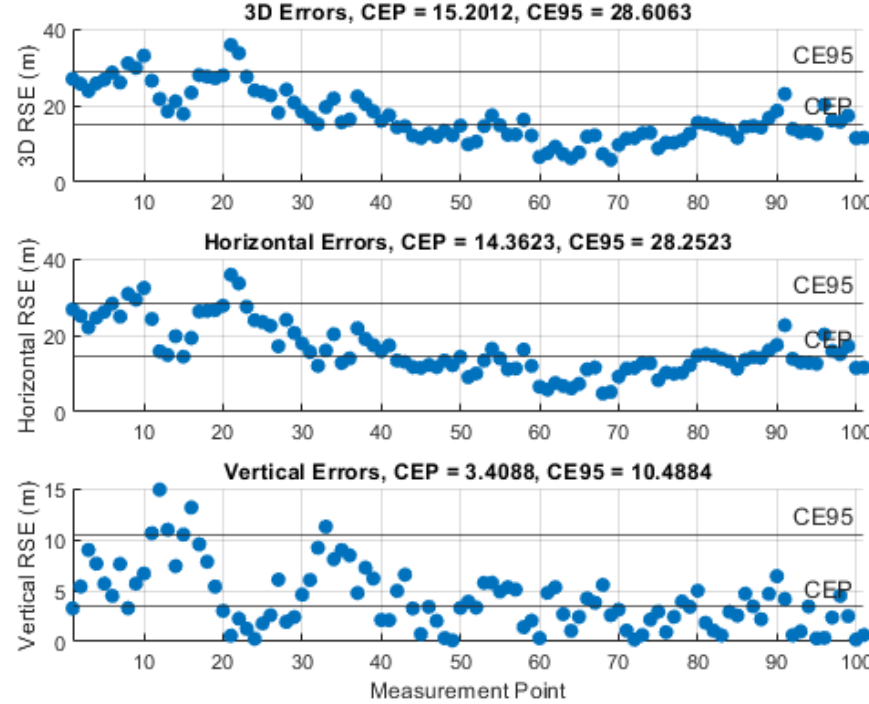
Figure 10. RSE evolution of the IPF solution with a measurement error SD, σ θ , ϕ , of 1 ◦.